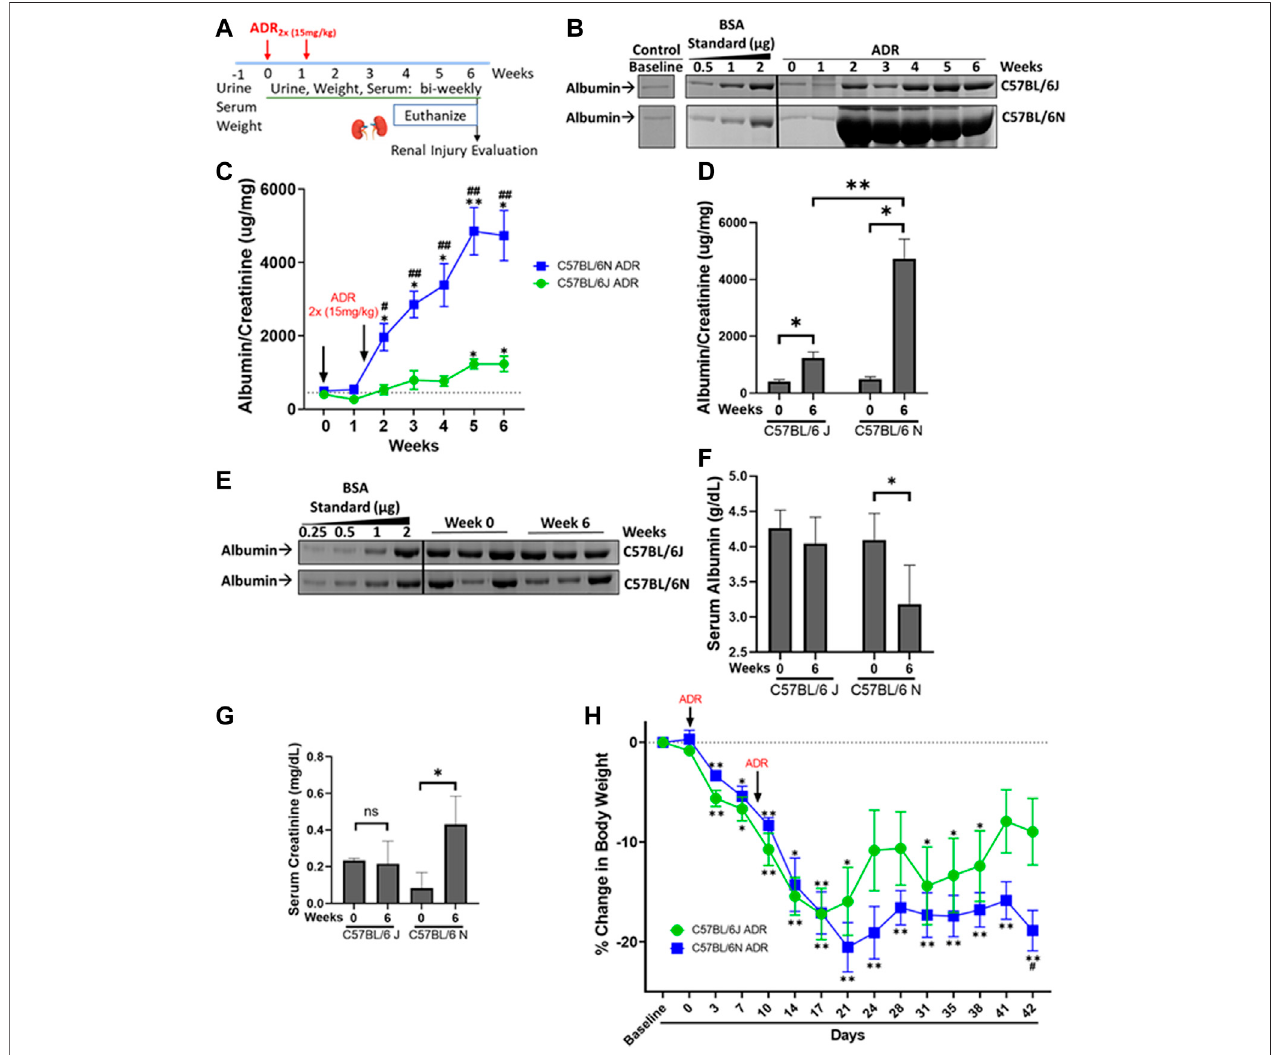
FIGURE 1 | ADR-Induced Proteinuria is Robust in the N and Modest in the J Substrain of C57BL/6 mice. (A) C57BL/6 J and N mice were injected with ADR (15 mg/kg/bw,i.v.)twice(Day0andDay9).Urine,serum,andweightwerecollectedthroughoutthestudy,andthemicewereeuthanized6 weeksafterthe fi rstinjection, on Day 42, at which timethe kidneys were harvested. (B) Representative urine gels with albumin bands are shown. Equal volumes of urine (5 µl) were analyzed by SDS- PAGEandCoomassieBluestaining.BSA(bovineserumalbumin)standardswereloadedatdeterminedamountsandusedtomakeadensitometrystandardcurve todetermine albumin concentration.Urine from healthy un-injected micewereused ascontrol. (C) Albumin/creatinine ratiowasdetermined and plotted(* p < 0.05, ** p < 0.01 vs. baseline of the same substrain, # p < 0.05, # p < 0.01 vs. J substrain at same week, Student t -test, n = 4/substrain). Dashed line parallel to X axis denotes the baselinealbuminuria (D) Albumin/creatinineratiosplottedfromurinesamplesfromWeek0andWeek6forJandNsubstrains(* p < 0.05,** p < 0.01,Student t -test, n =4/ substrain). (E) Representativeserum gelswithalbumin bandsshown.Equalvolumesofdilutedserum (1 µlof20Xdilution)wereanalyzedbySDS-PAGEandCoomassie Blue staining. BSA (bovine serum albumin) standards were loaded at determined amounts and used to make a densitometry standard curve to determine albumin concentration. (F) Albuminvalues weredeterminedand plotted (* p < 0.05vs. baseline,Student one tailed t -test, n =4/substrain). (G) Serum creatininelevelsfrom Week 0andWeek6ofbothJandNsubstrainsareplottedasmeasuredbytheenzymaticcreatininetestkit(* p < 0.05). (H) DecreaseinpercentagebodyweightofbothJandN substrains of mice at various time points compared to baseline, throughout the study are plotted. (* p < 0.05, ** p < 0.01 vs. week 0 of same substrain, # p < 0.05 vs. J substrain of same week Student t -test, n = 4/substrain). Dashed line parallel to X axis denotes the baseline starting body weight.